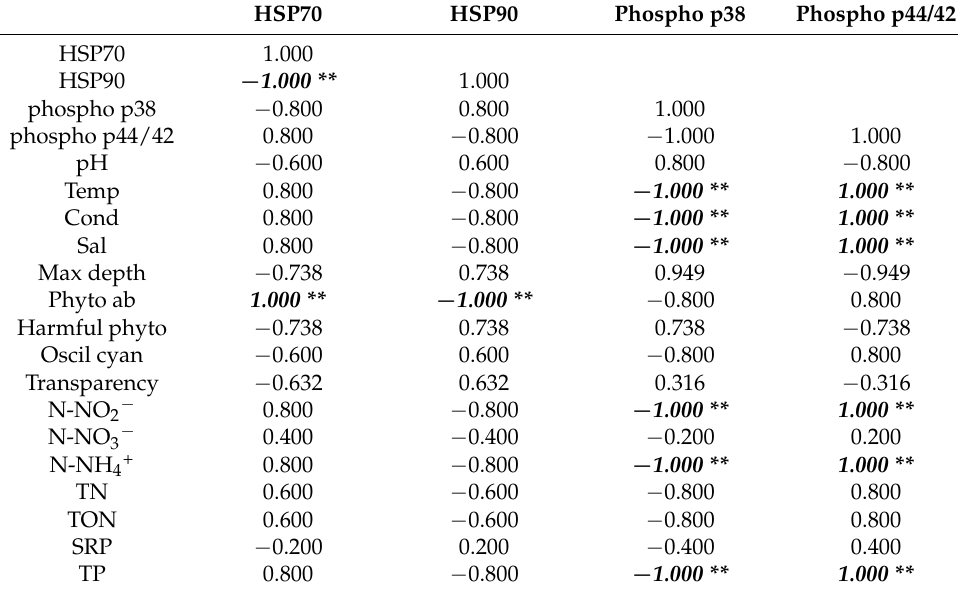
Table 3. Spearman’s rank correlation results of molecular biomarkers, water physicochemical pa- rameters and phytoplankton abundance. Significant correlation at the 0.01 level (** bold italics). Abbreviations according to Table